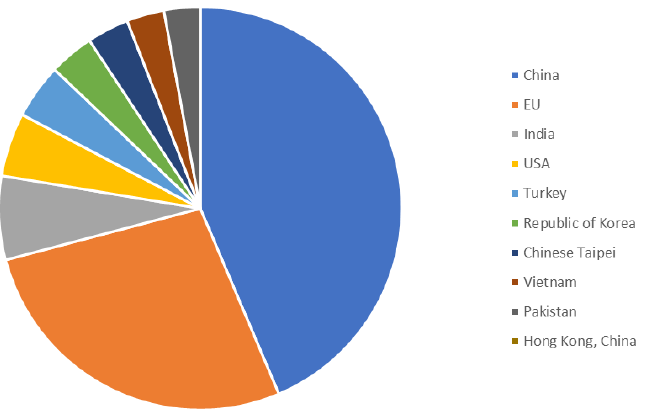
Figure 1. Major textile exporters in the world in 2018 [10]. Table 1. Chemical structures of dyes. Dye Chemical Structures